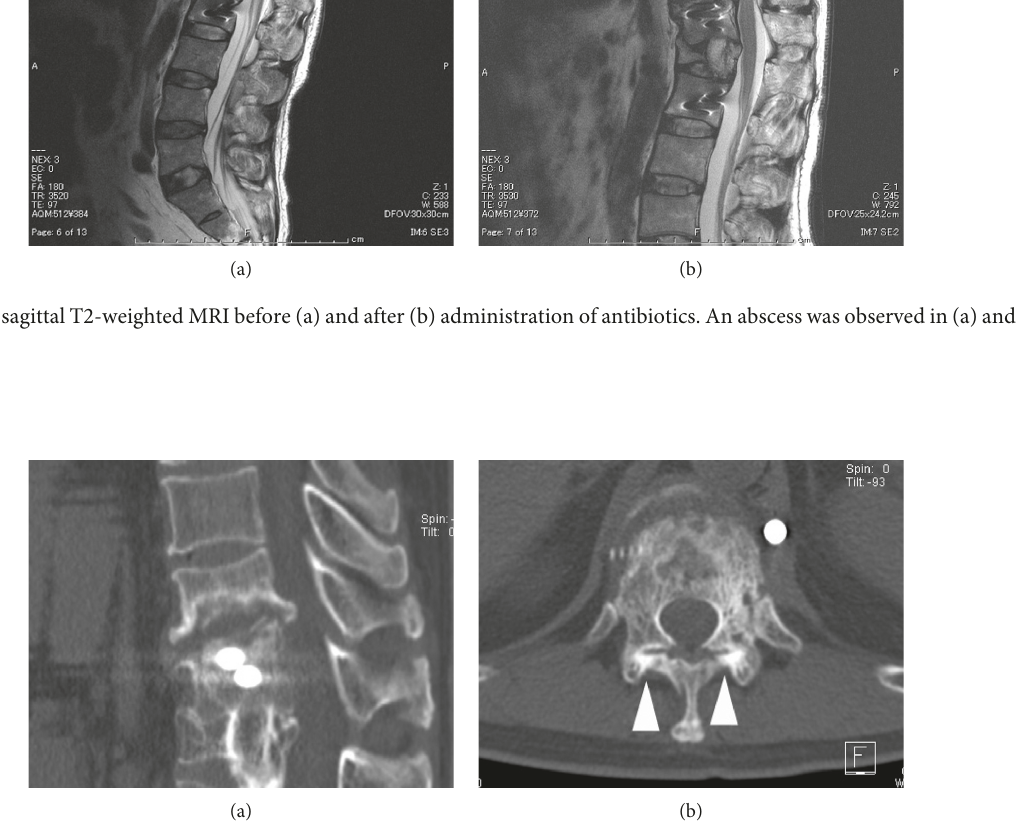
Figure 8: Case 3: sagittal (a) and axial (b) CT scans revealed facet joint union at the T11-12 level